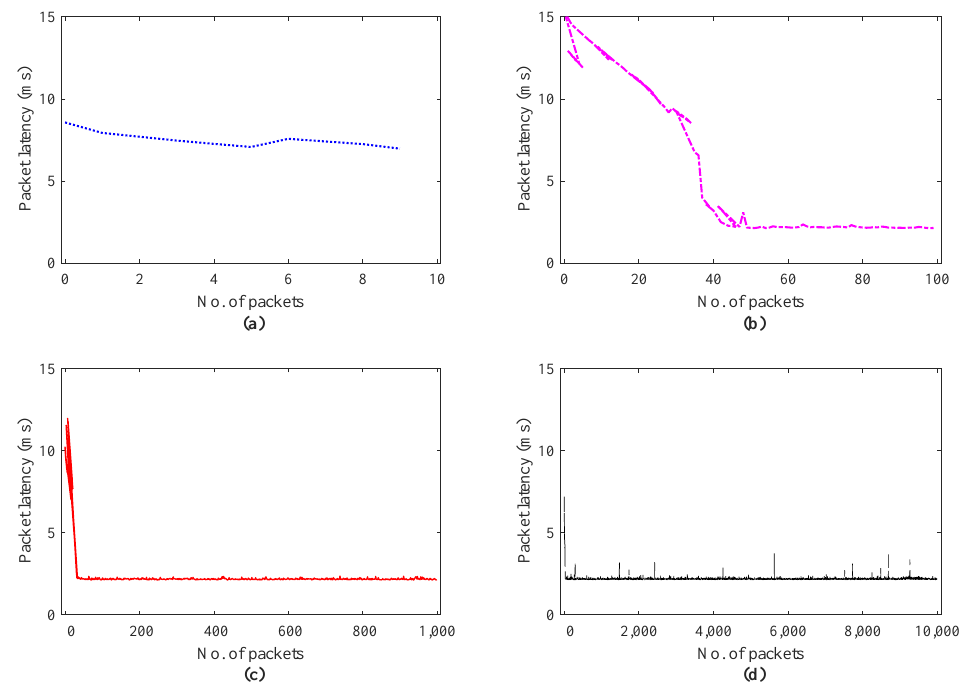
Figure 12. Packet latency investigation for scenario II real time haptic-driven remote operation; ( a ) data packets = 10, ( b ) data packets = 100, ( c ) data packets = 1000, ( d ) data packets =